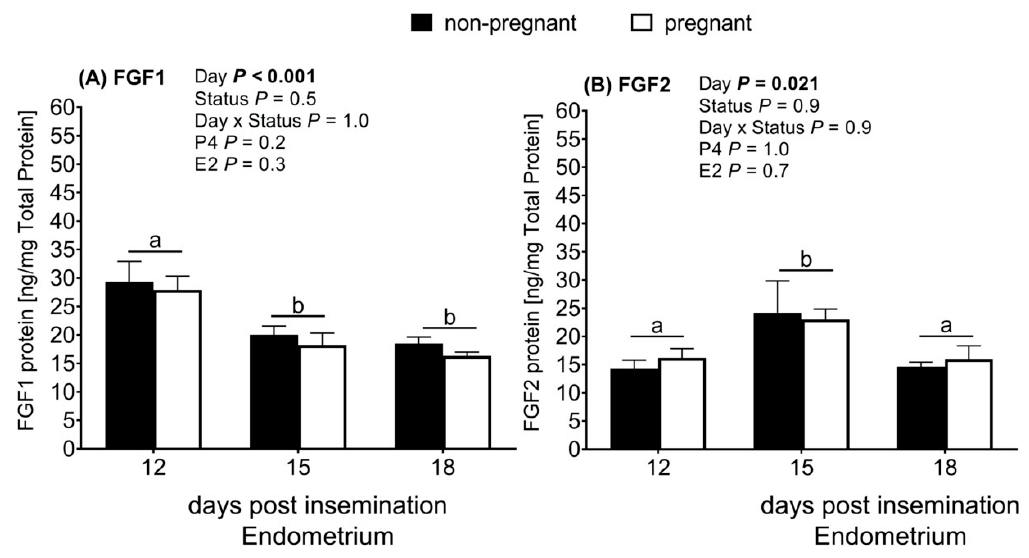
Figure 3. Fibroblast growth factor (FGF) protein abundance in the endometrium of nonpregnant ( n = 6 to 8) and pregnant ( n = 5 to 6) Simental heifers after insemination (insemination = Day 0). ( A ) FGF1 protein abundance; ( B ) FGF2 protein abundance. Days with a common letter (a,b) were not significantly different. Differences were considered statistically significant at a 95% confidence interval. While the endometrial FGF1 protein abundance decreased from Days 12 to 15 ( p < 0.001)